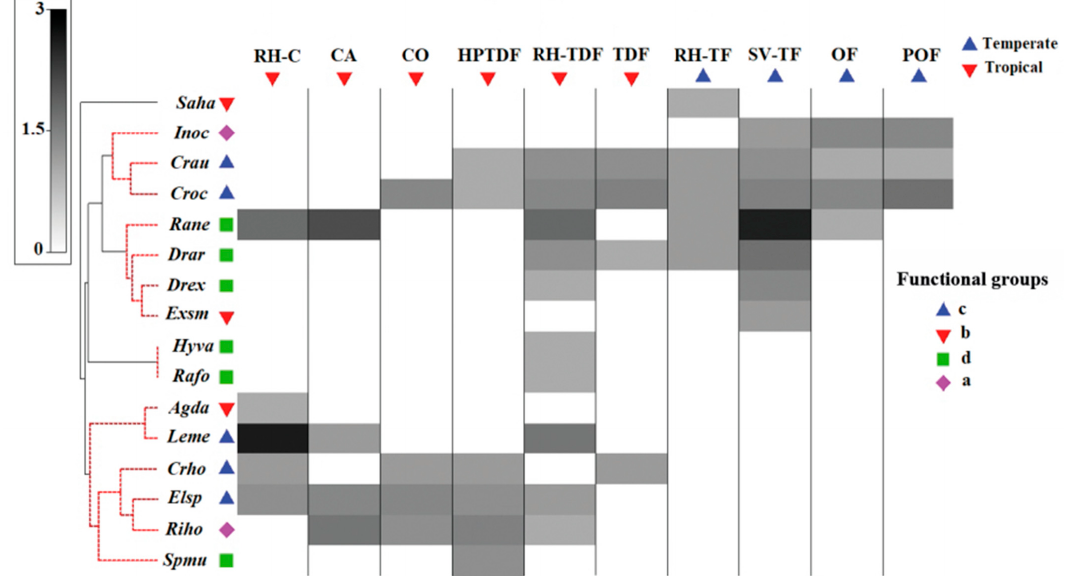
Figure 4. Shade diagram of amphibian species composition vs. land cover/use types. Shading intensity within the matrix indicates the species’ relative abundance. The dendrogram shows clusters found by the SIMPROF. Another cluster analysis and a SIMPROF procedure determined the amphibian functional groups: ( a ) Group ‘‘a’’ was featured by toxicity, big size, and terrestrial habitat; ( b ) Group ‘‘b’’ by a dorsal pattern; ( c ) Group ‘‘c’’ by the reproductive mode; and ( d ) Group ‘‘d’’ by the diet and period of activity. Codes: sugar cane field (CA), riparian habitat surrounded by crops (RH-C), cornfield (CO), highly perturbated tropical dry forest (HPTDF), tropical dry forest (TDF), riparian habitat surrounded by tropical dry forest (RH-TDF), riparian habitat surrounded temperate forest (RH-TF), secondary vegetation surrounded by temperate forest (SV-TF), oak forest (OF) and pine-oak forest (POF), Craugastor hobartsmithi (Crho), Craugastor occidentalis (Croc), Craugastor augusti (Crau ), Eleutherodactylus sp. (Elsp), Incilius occidentalis (Inoc), Rhinella horribilis (Riho), Exerodonta smaragdina (Exsm), Dryophytes arenicolor (Drar), Dryophytes eximius (Drex), Sarcohyla hapsa (Saha), Leptodactylus melanonotus (Leme), Hypopachus variolosus (Hyva), Agalychnis dacnicolor (Agda), Rana aff. forrieri (Lifo), Rana neovolcanica (Line), and Spea multiplicata (Spmu).